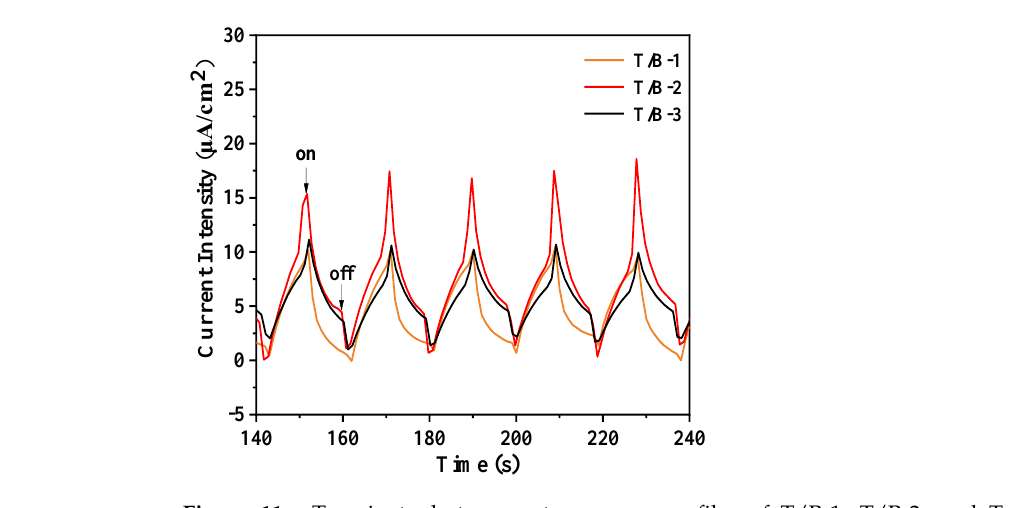
Figure 11. Transient photocurrent response profiles of T/B-1, T/B-2, and T/B-3 composite fiber heterojunctions.